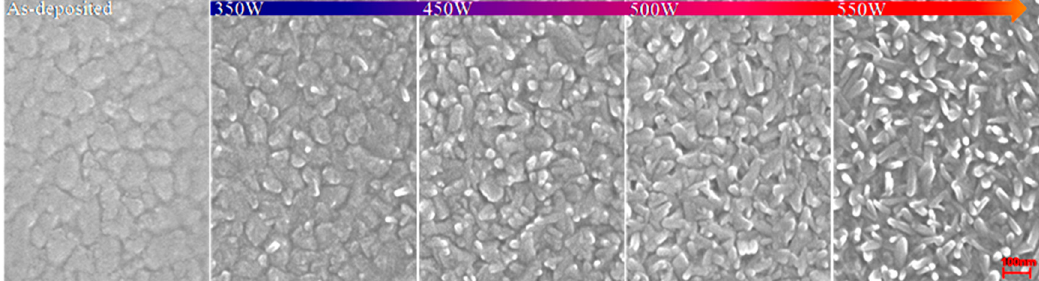
Figure 2. Scanning electron microscope (SEM) images of the surface morphologies inVO 2 films irradiated with Ar/O plasma at different powers.